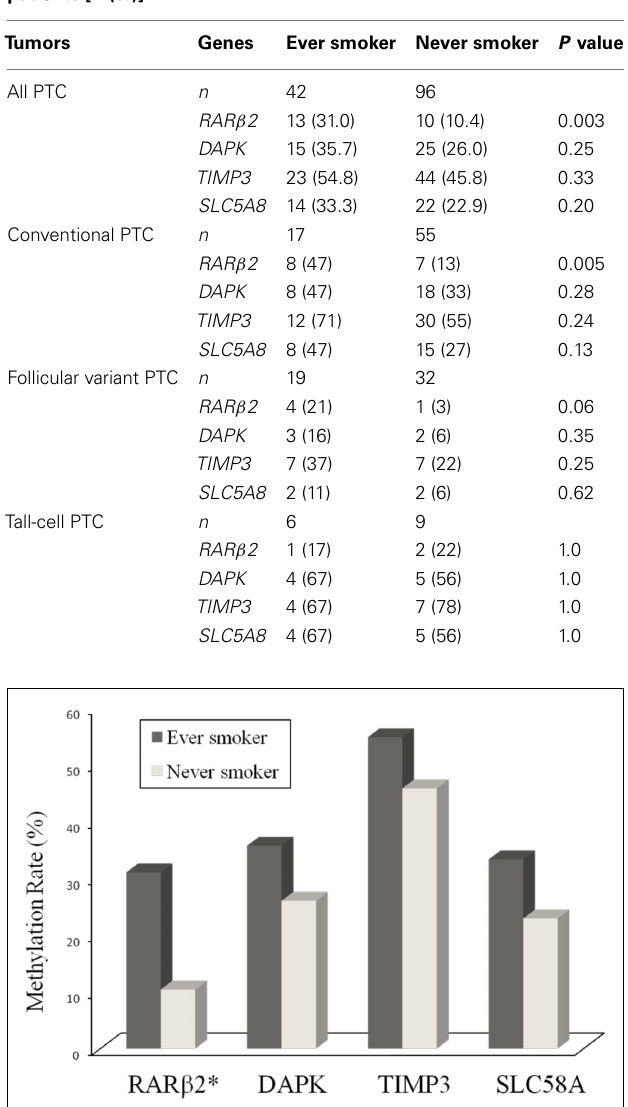
Table 3 | Relationship of methylation of the RAR β 2 , DAPK , TIMP3 , and SLC5A78 genes in papillary thyroid cancer (PTC) with smoking of patients [ n (%)].